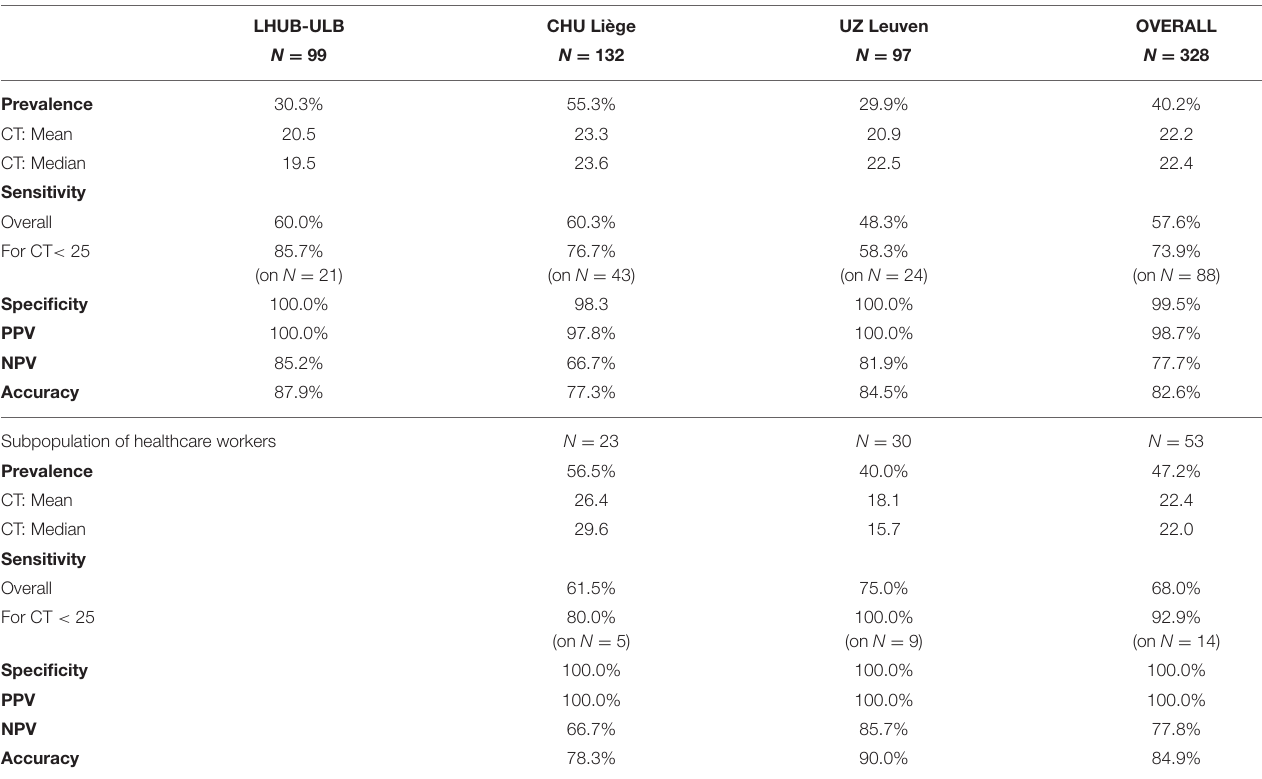
TABLE 2 | Clinical performance